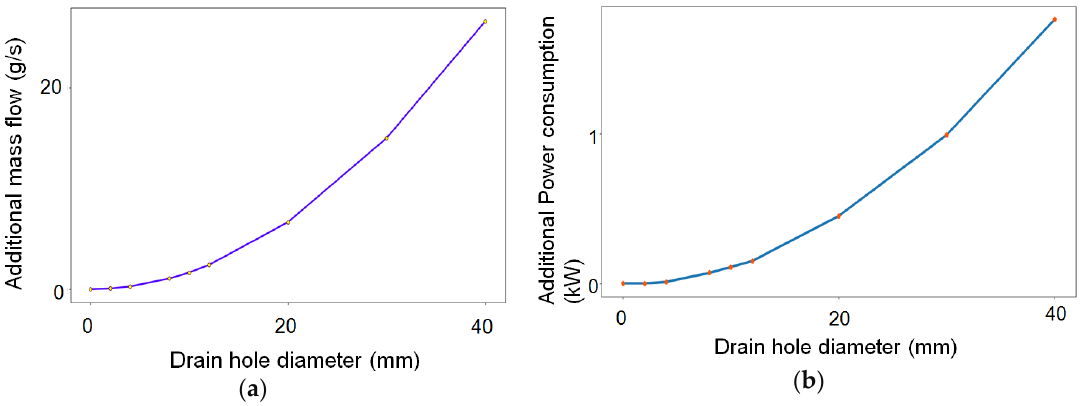
Figure 18. Drain hole size sensitivity with ( a ) mass flow or ( b ) power consumption.